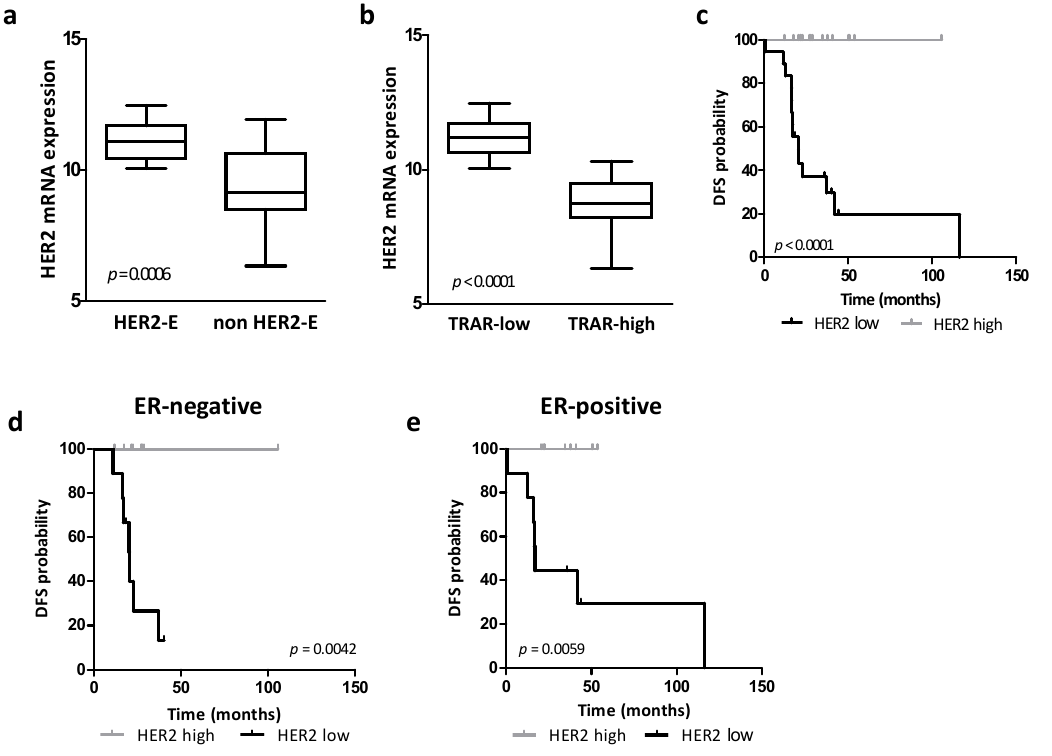
Figure 1. Association between HER2 mRNA expression, HER2-addiction and patient prognosis. ( a , b ) Association between PAM50 ( a ) and TRAR ( b ) classification and HER2 mRNA expression in primary HER2-positive BCs of the GHEA cohort. p values obtained by Student’s t test. ( c – e ) Kaplan- Meier analysis of patients in the GHEA cohort classified according to HER2 mRNA levels in the entire cohort (n = 36, c ), and in ER-negative (n = 18, d ) and ER-positive (n = 18, e ) cohorts. The HER2 mRNA median expression value in the entire cohort was used as the cutoff to define the high and low expression groups. p values by log-rank test. HER2-E: HER2-enriched.